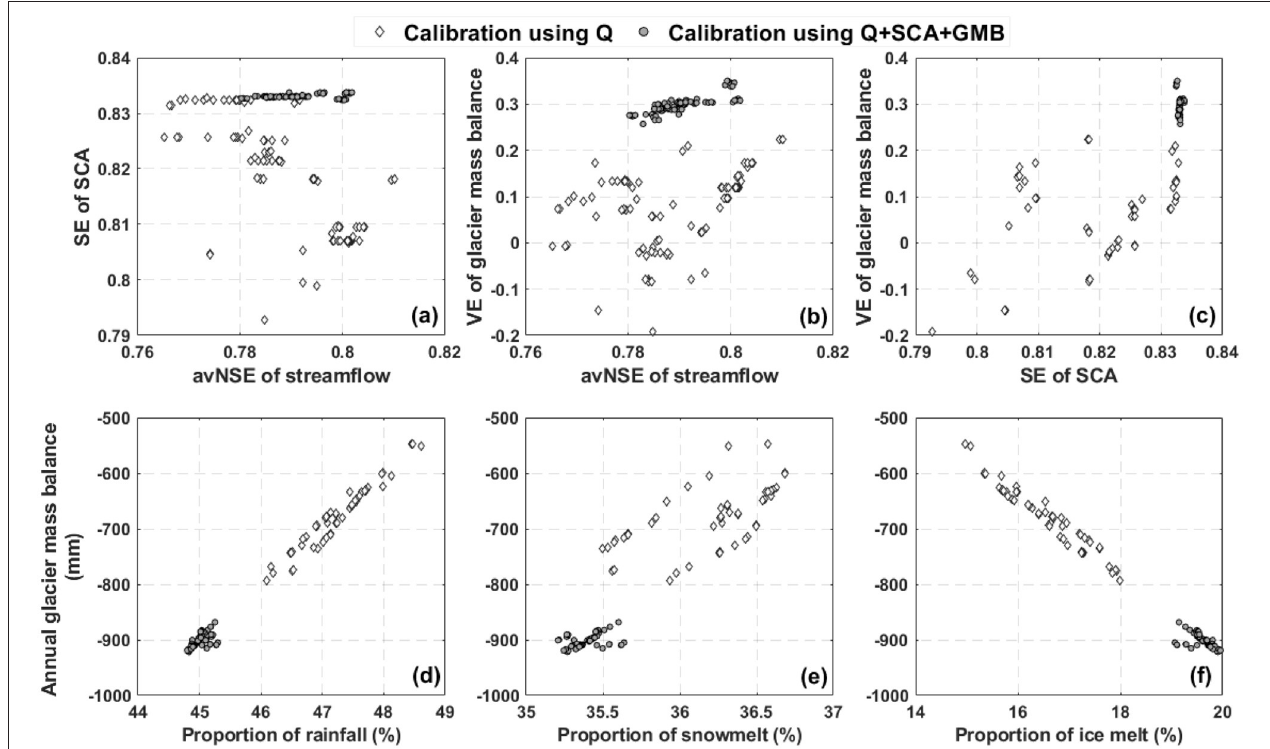
FIGURE 10 | Uncertainties of the model performance (a–c) , and the simulations of water input sources and glacier mass balance (d–f)